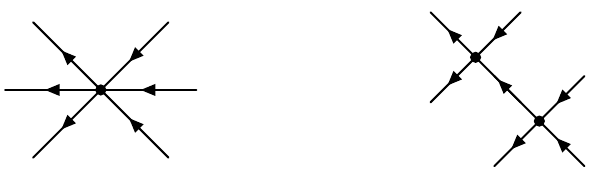
Figure 3 . Contact and dog-diagram contribution to three-body